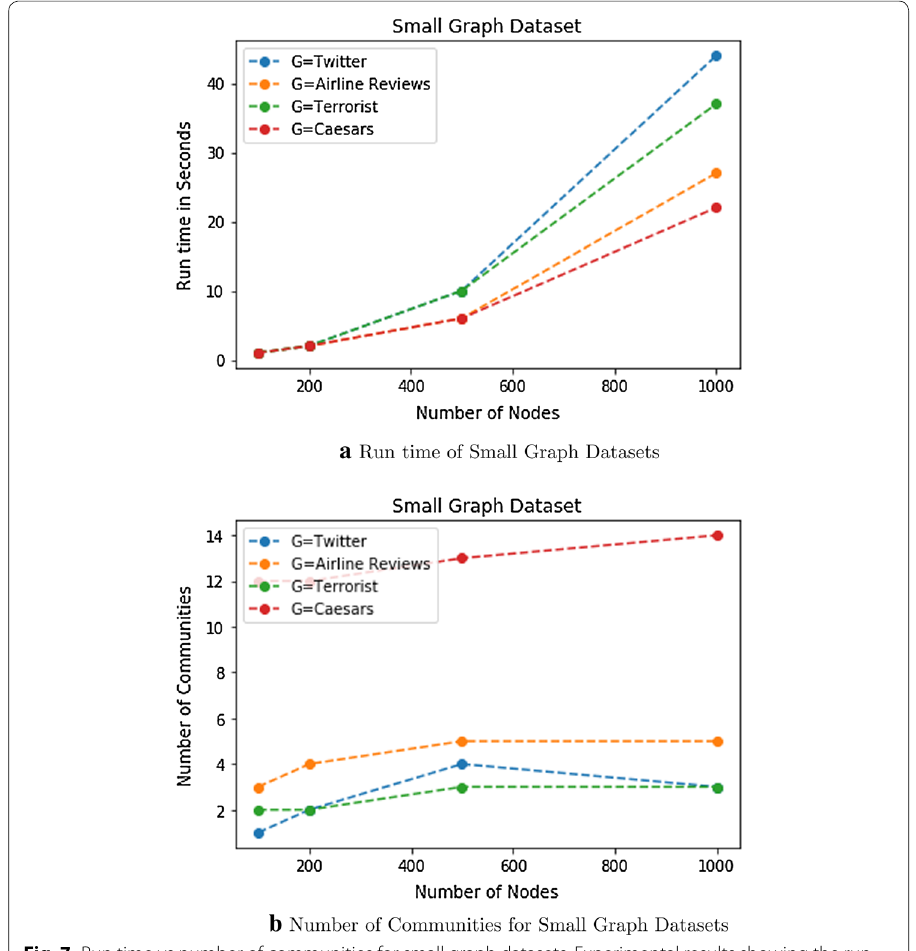
Fig. 7 Run time vs number of communities for small graph datasets. Experimental results showing the run time and the number of communities generated for small graph datasets using the proposed